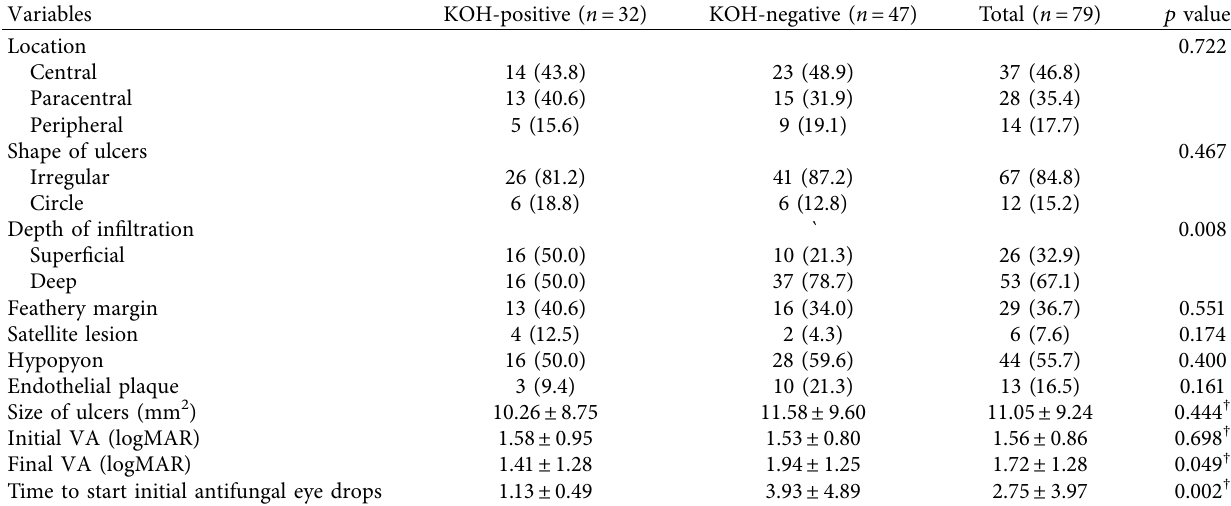
Table 3: Clinical manifestations for eyes with culture-proven Fusarium keratitis divided by the initial KOH smear.